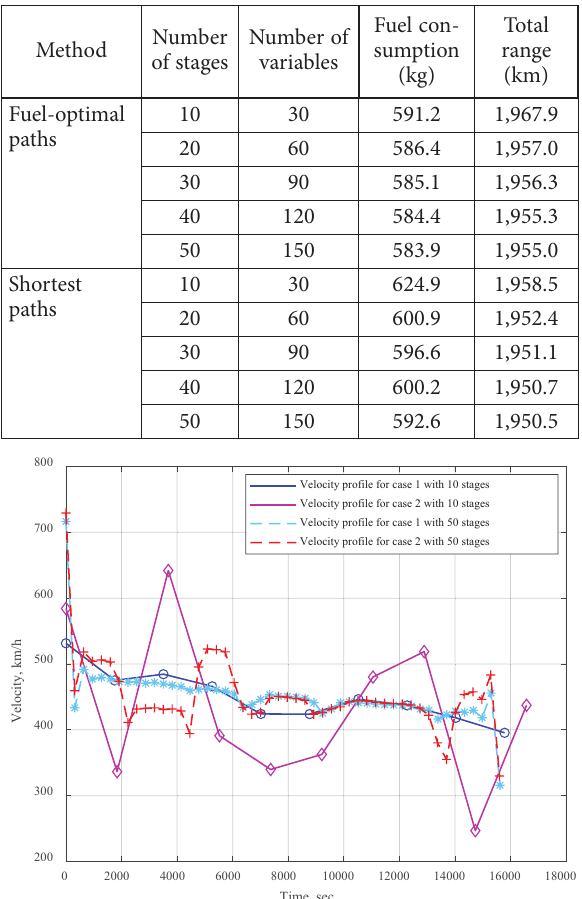
Table 3. Comparison of fuel and shortest-path optimization results for scenario 1